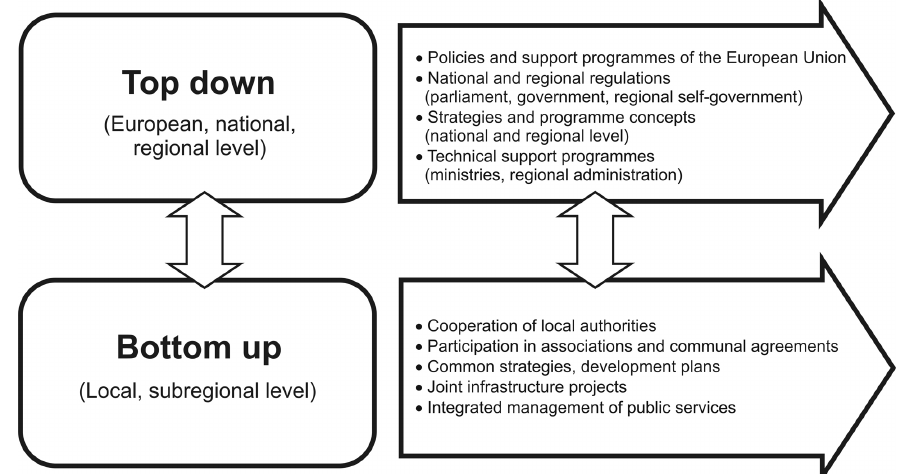
Fig. 1. Top-down and bottom-up activities for management integration in functional urban areas. source: own